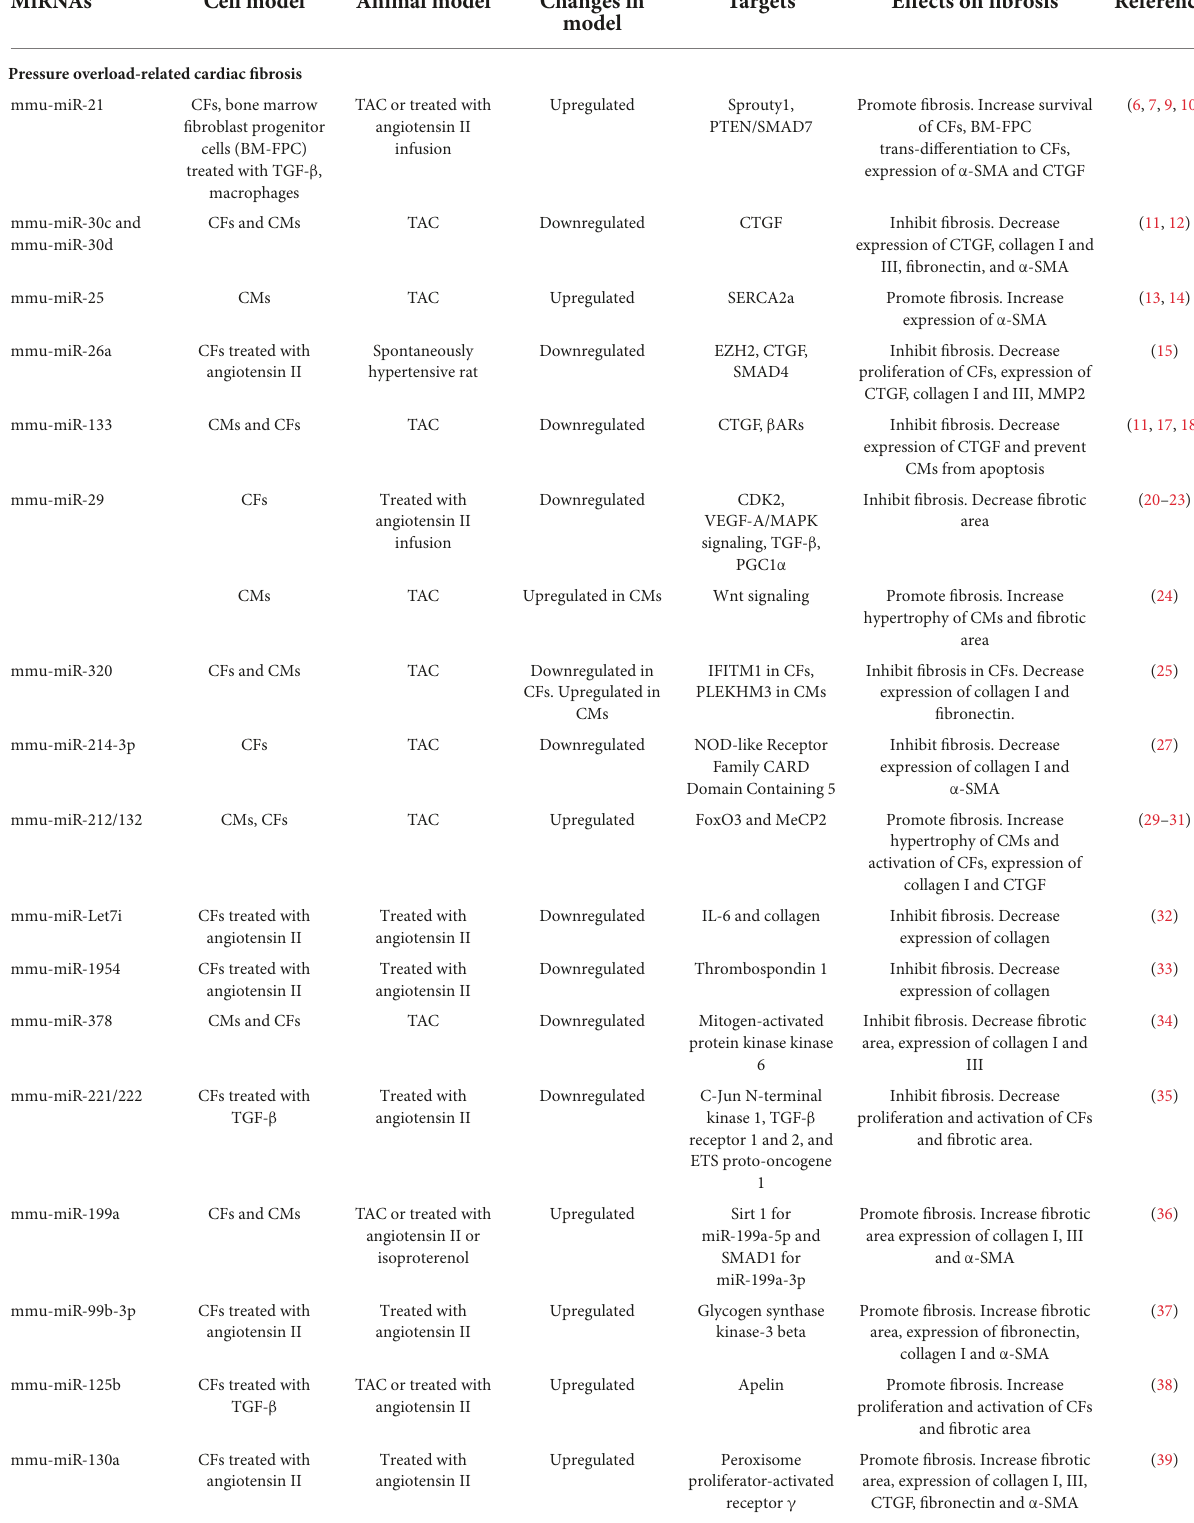
TABLE 1 Effects of miRNAs on cardiac